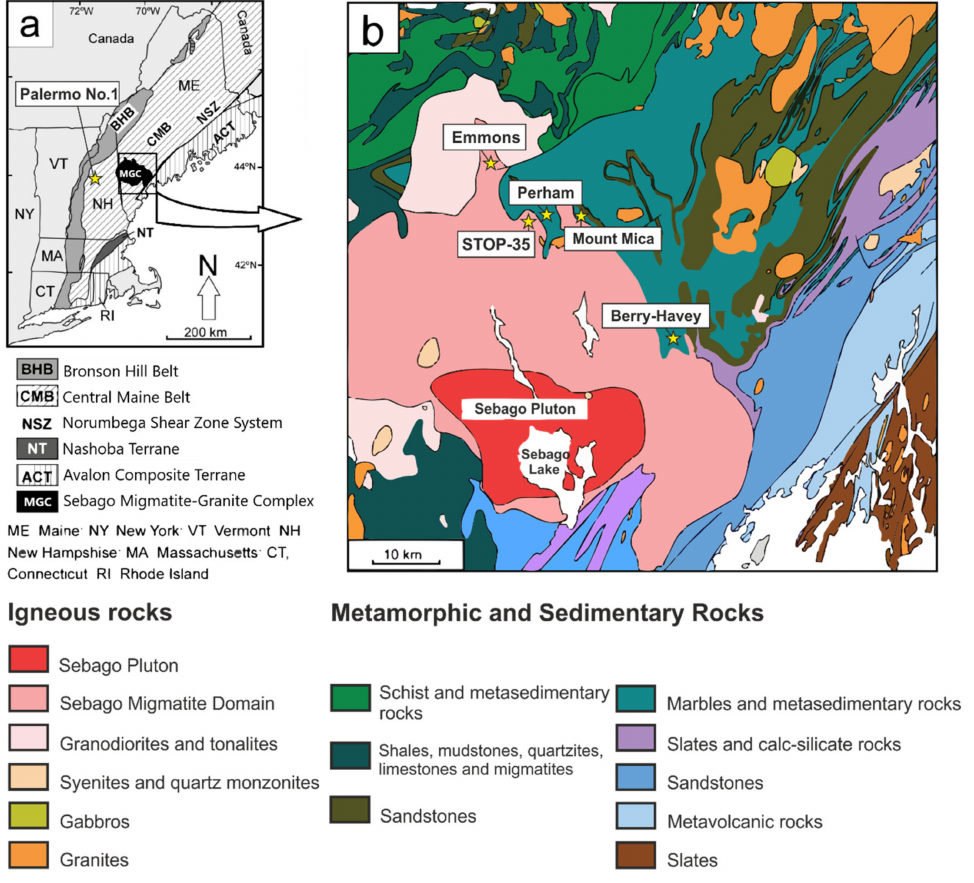
Figure 1. ( a ) Geographic location of the Oxford and Grafton pegmatite fields. Modified from [21]; ( b ) Lithological map of the Oxford pegmatite field modified from